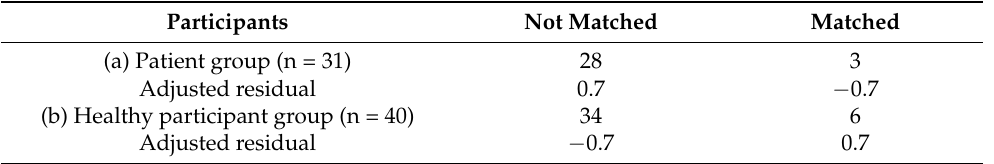
Table 3. Agreement between subjective FER and FER based on MTCNN face detection in the patient and healthy participant